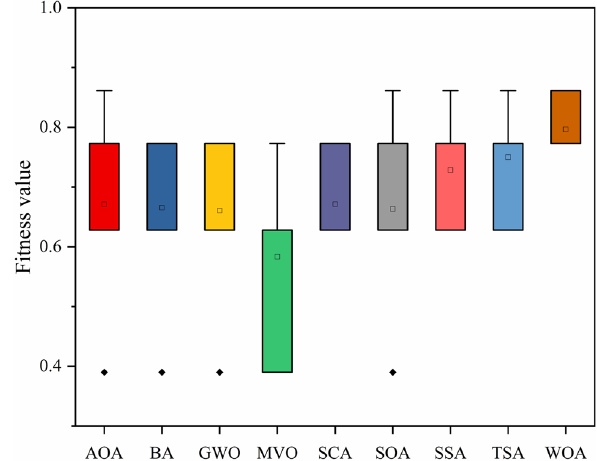
Fig. 13 The ANOVA tests of the algorithms for case 3